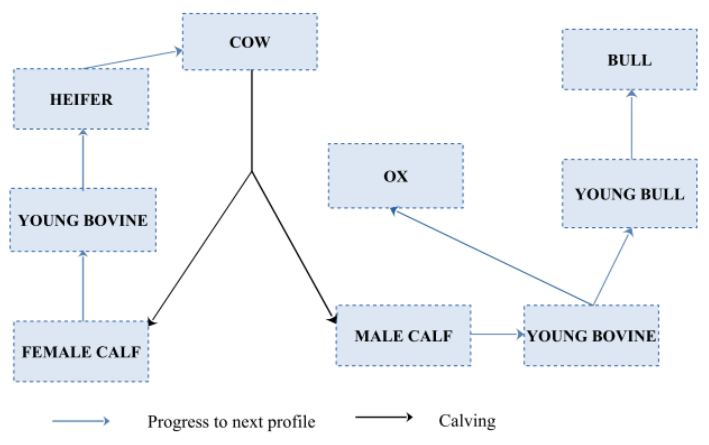
Figure 3. Cattle herd structure [26].